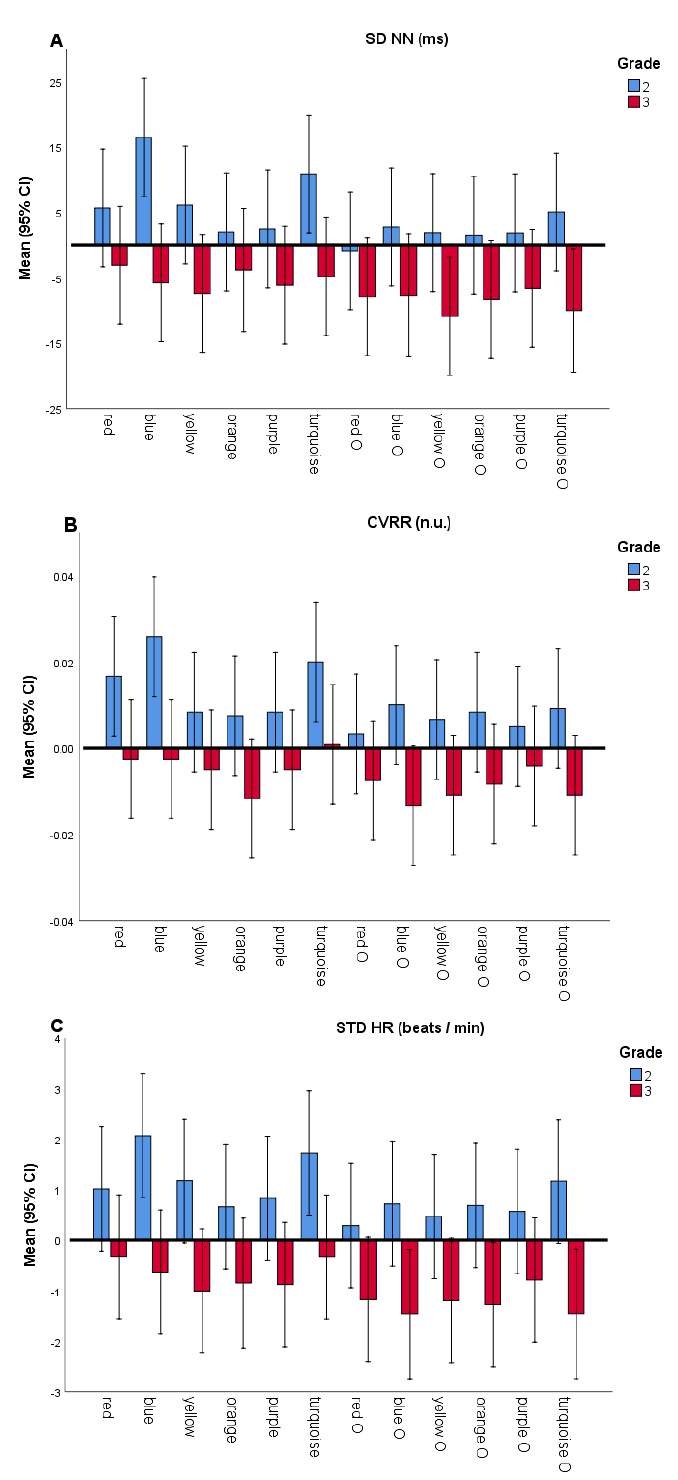
Figure 2. SDNN, CVRR and STD HR by grade and color (normalized on white color). ( A ) Nor- malized SDNN values (ms), ( B ) Normalized CVRR values (n.u.) and ( C ) Normalized STD HR (beats/min). Normalized values of each parameter are calculated by subtracting the parameter value for white background from the values for each of the background/overlay colors. Bar plots show the normalized data for all background and overlay colors (overlay colors labeled with "o" on x-axis), where second and third grader’s values are presented with blue and red colored bars, respectively. Error bars denote standard errors of the